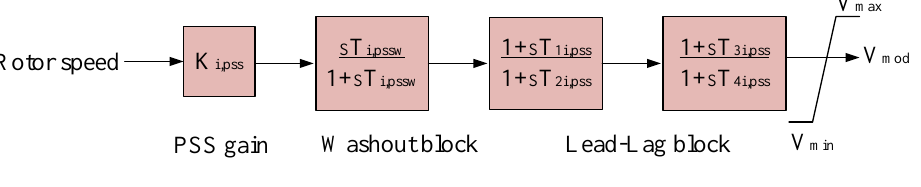
Figure 4. i th PSS structure.